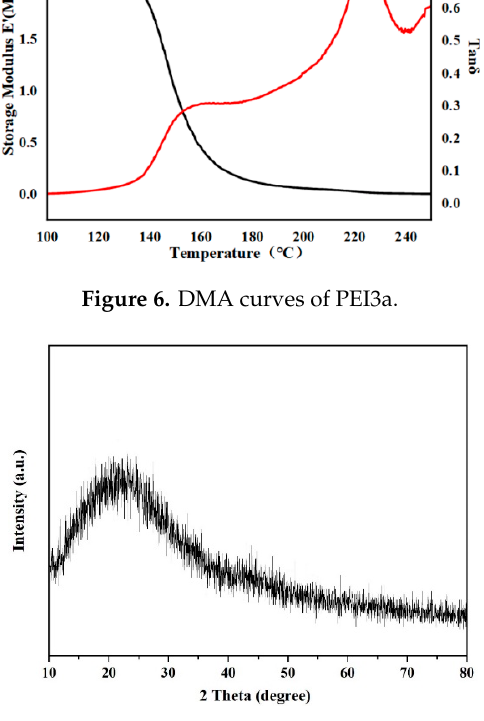
Figure 7. XRD curve of PEI3a.